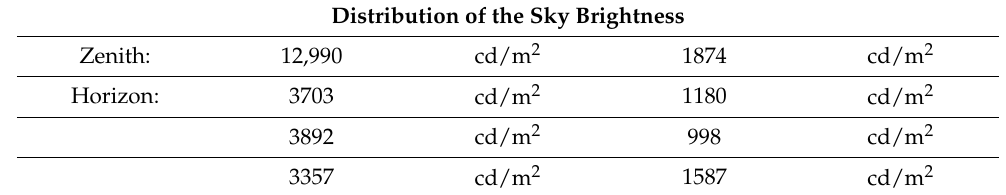
Table 5. Distribution of the sky brightness.